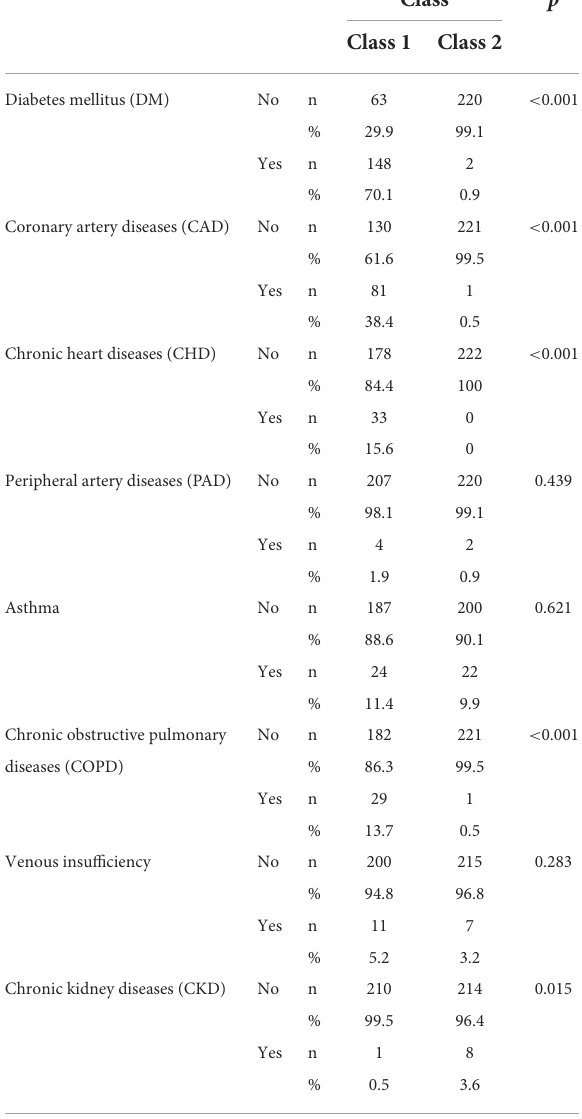
TABLE 5 Relations between classes and